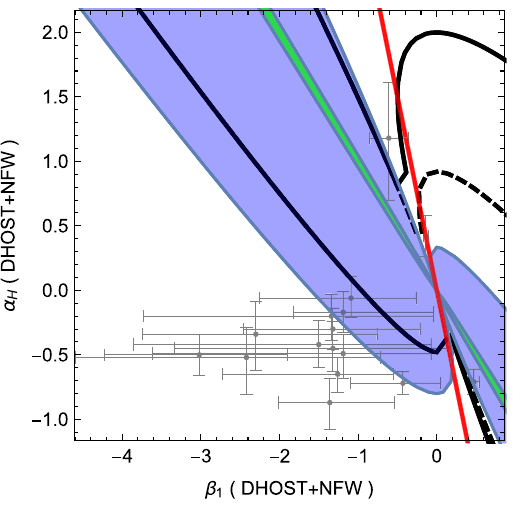
Fig. 4 Comparison of ETF parameter constraints from our DHOST analysis with the results from [18,20,114]. Left panel: Results under the assumption that DHOST mimicks dark energy. Dashed black lines are 1 σ constraints from this work for the case with SHMR prior; solid black lines are 1 σ constraints from this work for the case without the SHMR prior. Right panel: Results when DHOST is assumed to play the role of both dark energy and dark matter. Solid black lines are 1 σ